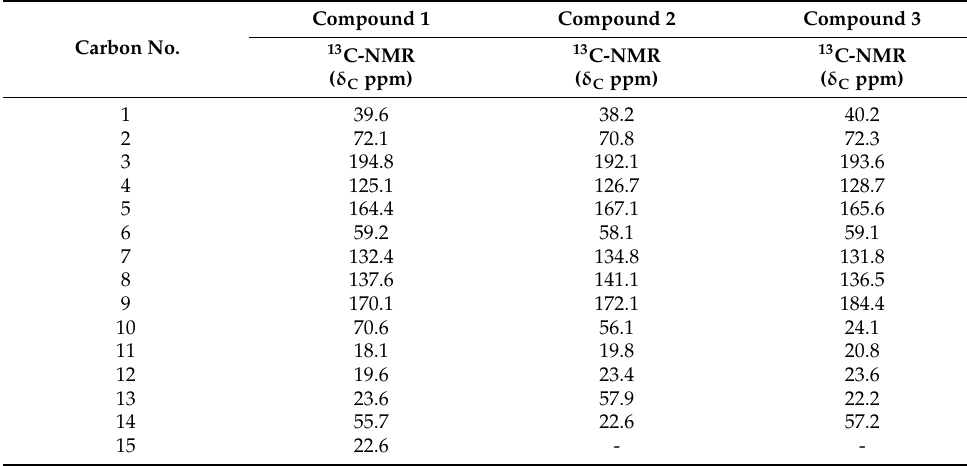
Table 2. 13 C NMR (125MHz, CDCl 3 ), δ C in ppm.